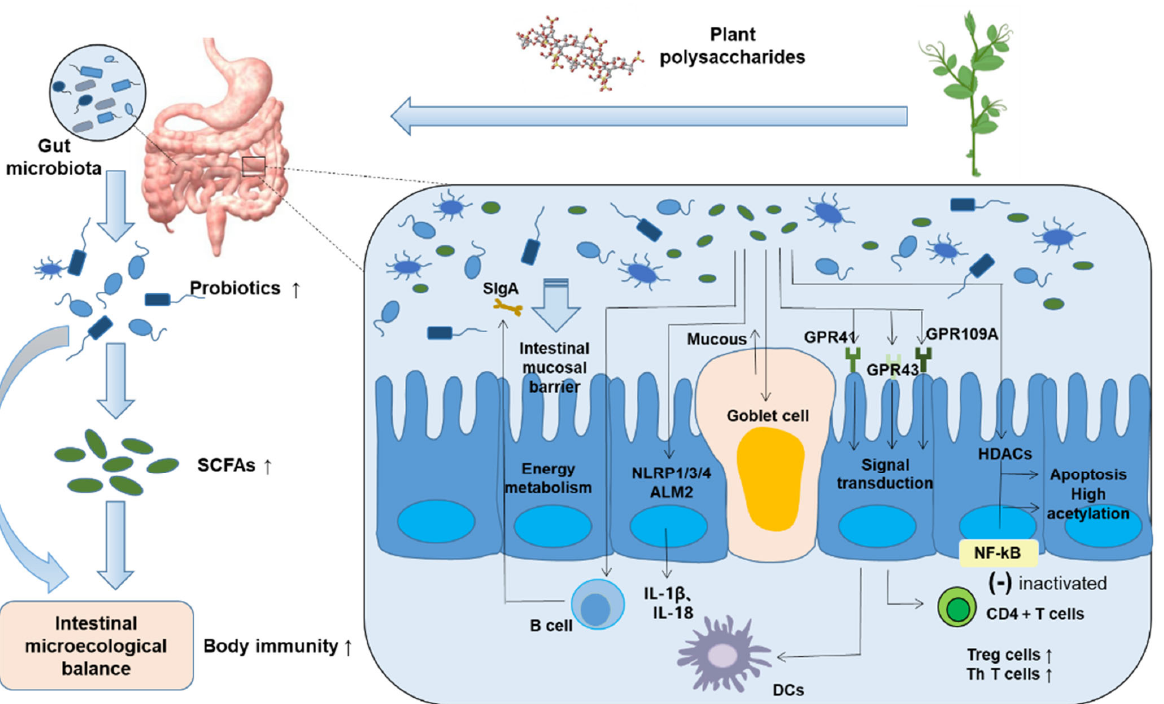
Figure 2. Probiotics and SCFAs participate in various immune ‐ related physiological and biochemi ‐ cal